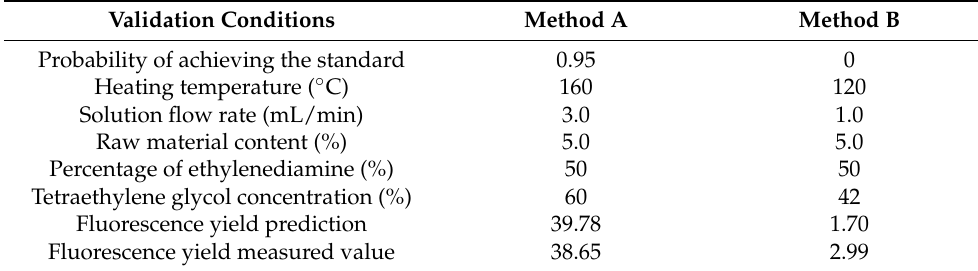
Table 1. Experimental validation conditions and results.